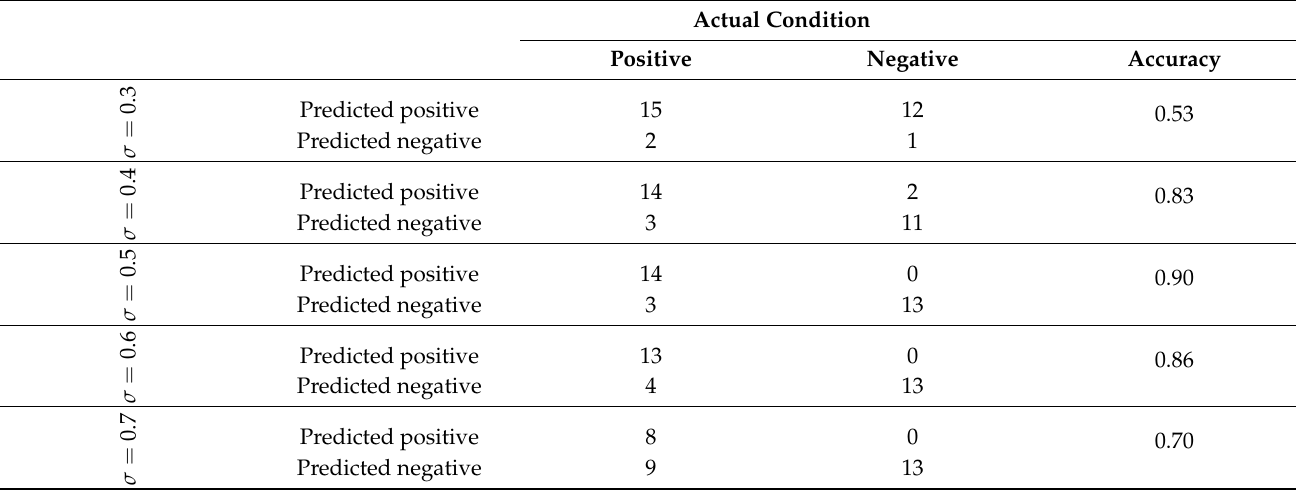
Figure 12. ROC curve of the triggering mechanism in a radar system. Table 2. Confusion matrix and accuracy of each threshold level in the attack to a radar